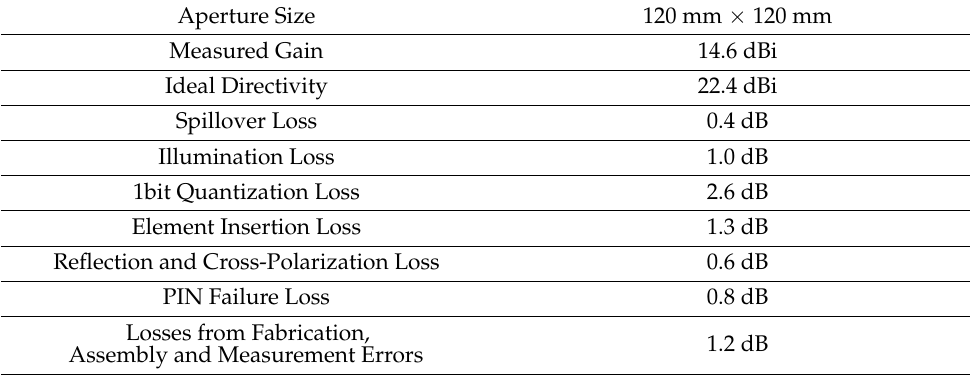
Table 3. Gain loss analysis for boresight beam.